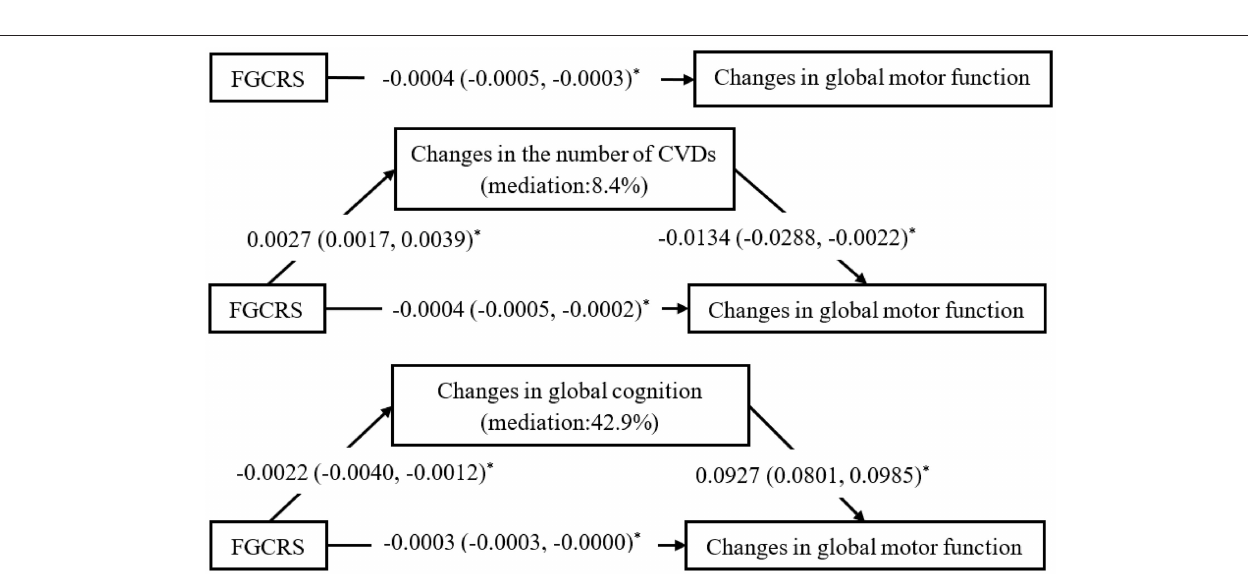
FIGURE 2 | Mediating effects of changes in the number of cardiovascular diseases (CVDs) and global cognitive function on the association between Framingham General Cardiovascular Risk Score (FGCRS) and global motor function changes. β -coefficients and 95% confidence intervals were calculated using bias-corrected bootstrapping. Mediation model adjusted for education, body mass index, alcohol consumption, physical activity, social activity, baseline number of cardiovascular diseases, and baseline global cognition score. * P < 0.05.